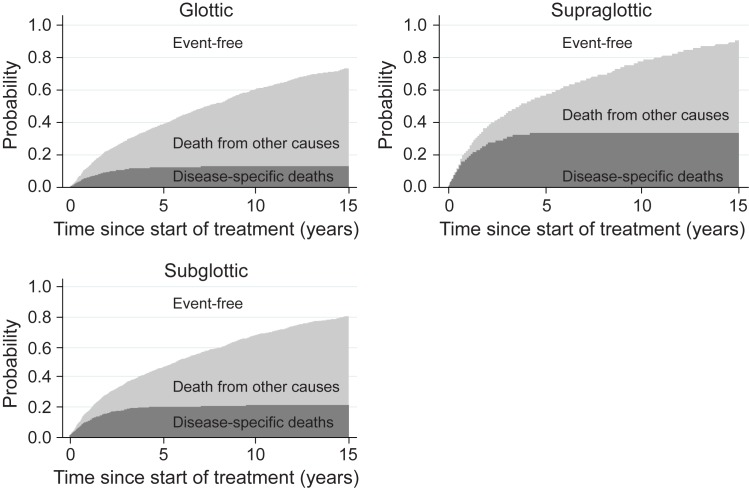
Stacked cumulative incidence of disease-specific death, death from other causes and disease-free survival by subsite during 15 years' follow-up.